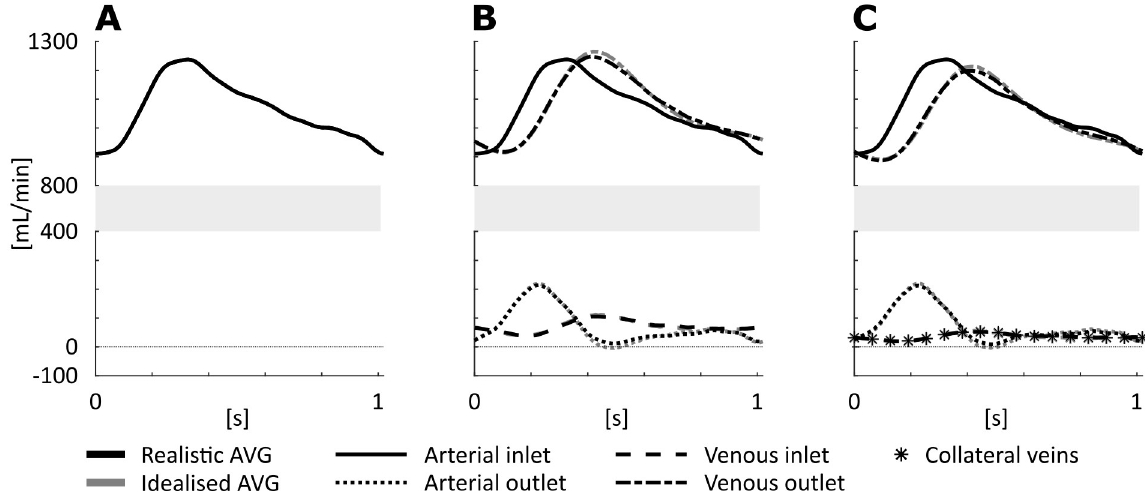
Fig 4. Overview of the flows over the in- and outlets of the 3D geometry and over the collateral veins for distal boundary condition model ZF-DB (A), AVC-DB (B) and AVCE-DB